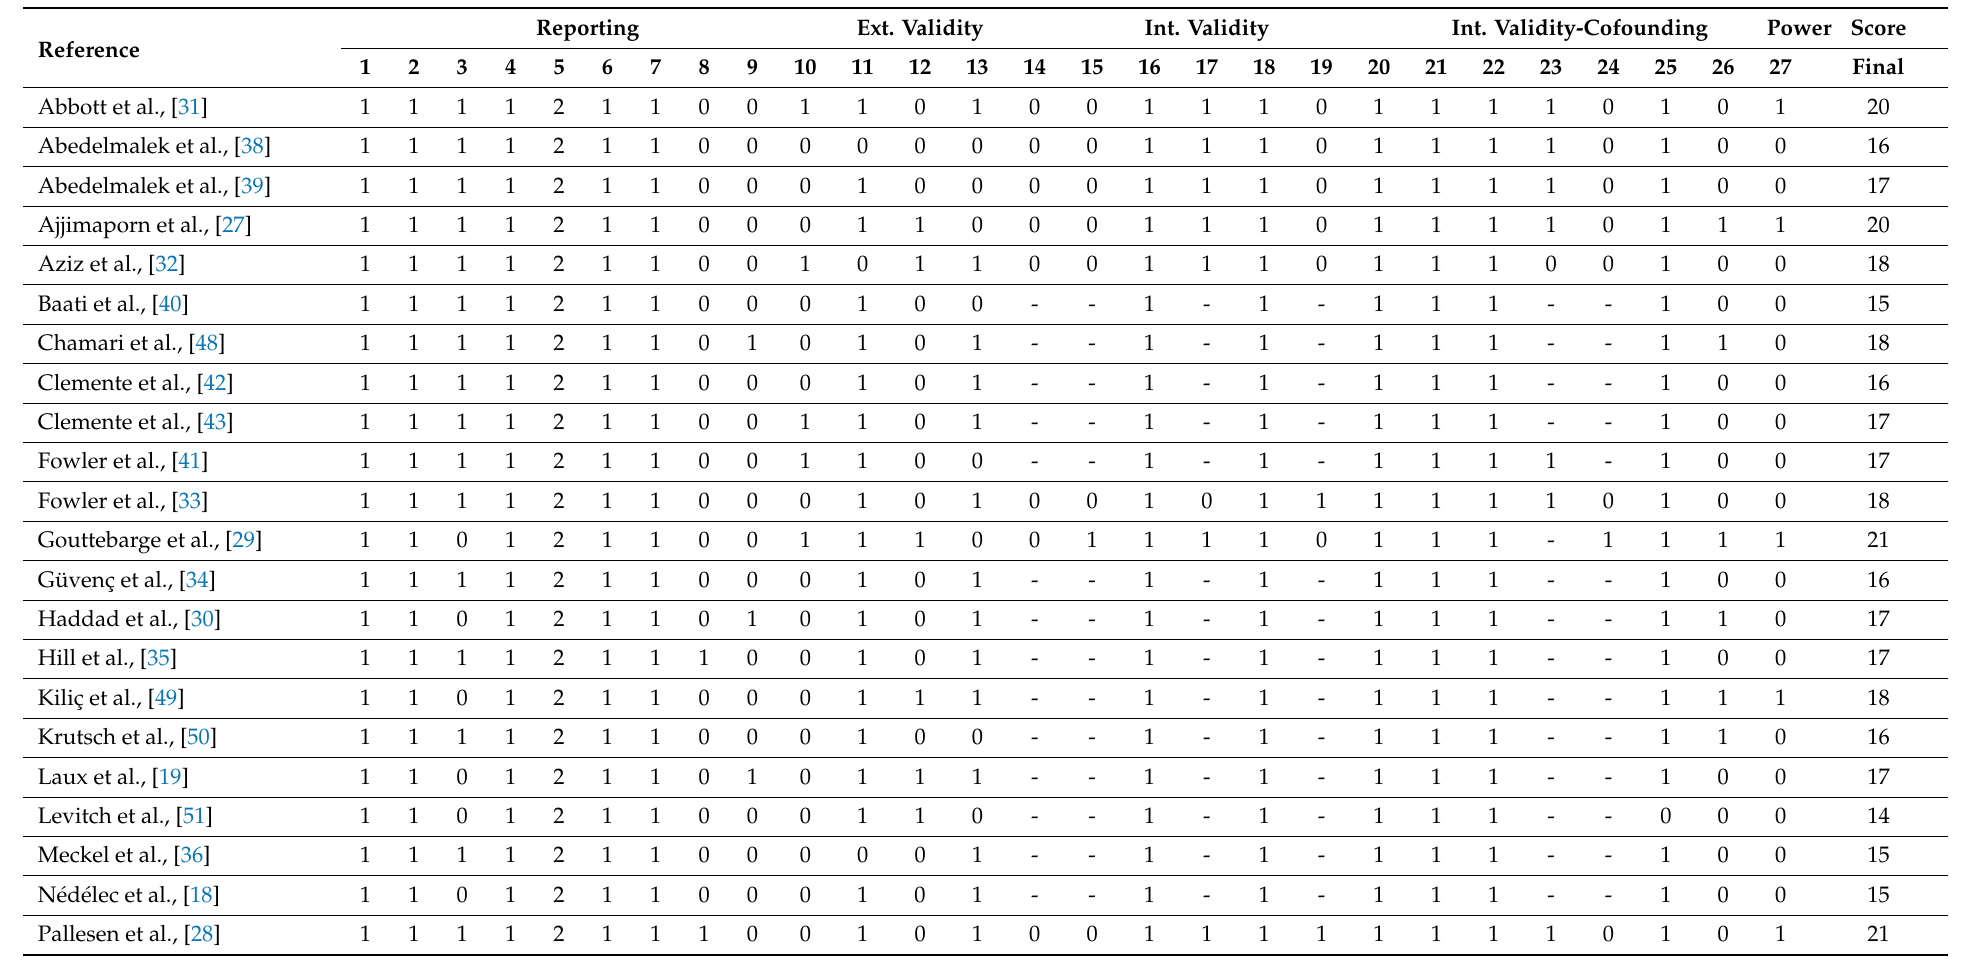
Table 2. Methodological assessment of the included